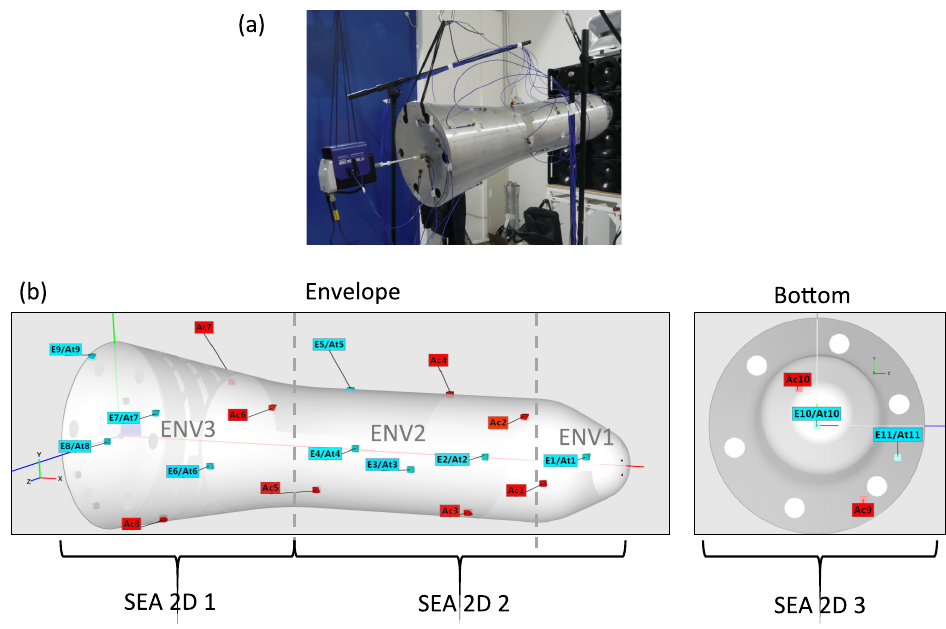
Figure 14. ( a ) The experimental setup. ( b ) HB–2 subsystem definition and the location of the excited and measured points. The blue dots indicate the points that were used for both excitation and response measurement. The red dots indicate the points that were used only for the acceleration response measurement.